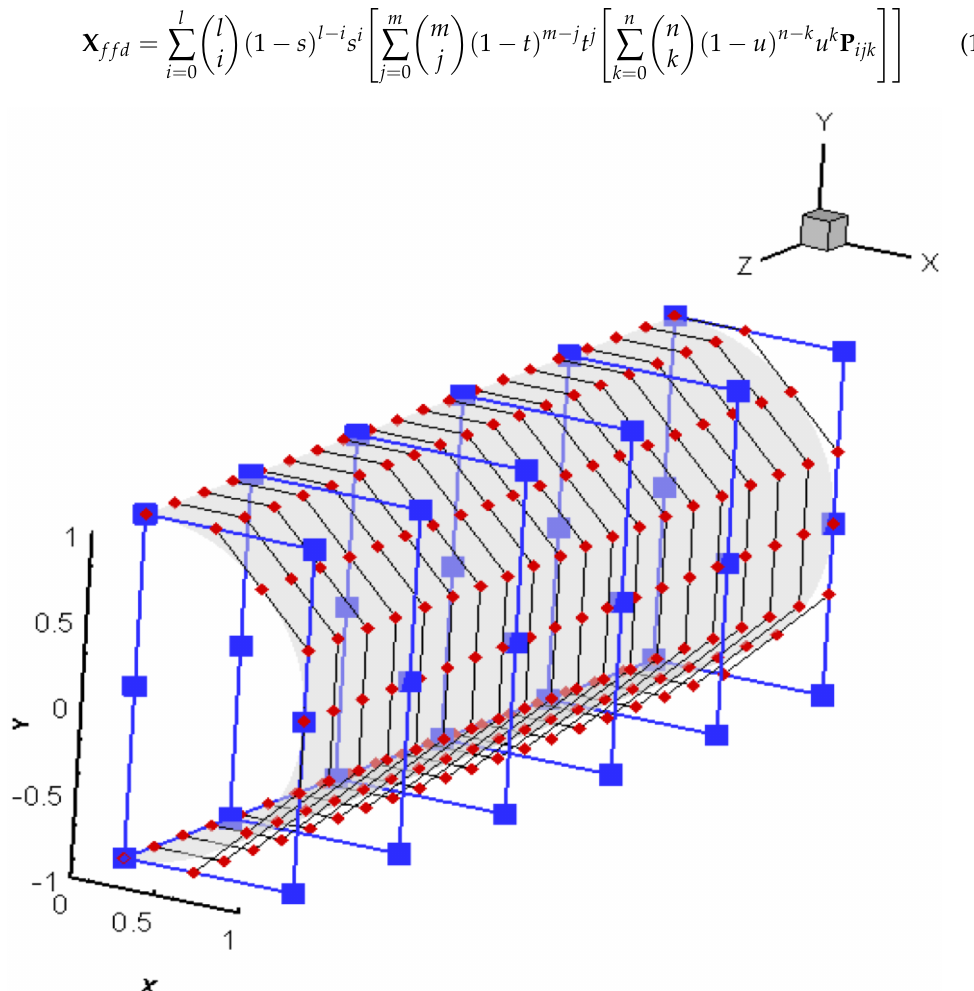
Figure 6. B − spline control points embedded inside the FFD volume. The initial B-Spline geometry’s control points are red, and the FFD control points are